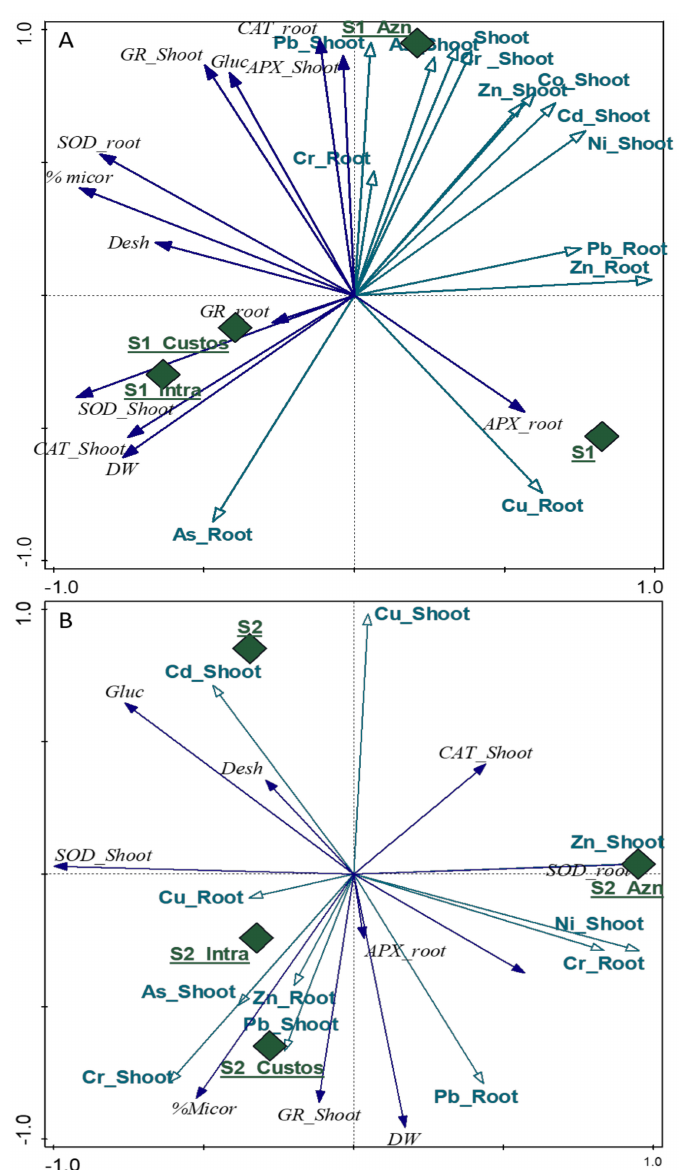
Figure 6. Principal component analysis (PCA) for the analyzed soil 1 (S1) ( A ) and soil 2 (S2) ( B ). The treatments used (control: S1 and S2; Aznalcollar: Azn; Intraradices: Intra; Custos: Custos) are correlated with green diamonds; the concentration of heavy metals in roots and shoots with green arrows; and the biological parameters (enzymatic antioxidant systems (APX, GR, CAT, SOD), enzymatic soil activity (Desh and Gluc), plant biomass (DW), and percentage of mycorrhization (%Micor) with dark blue